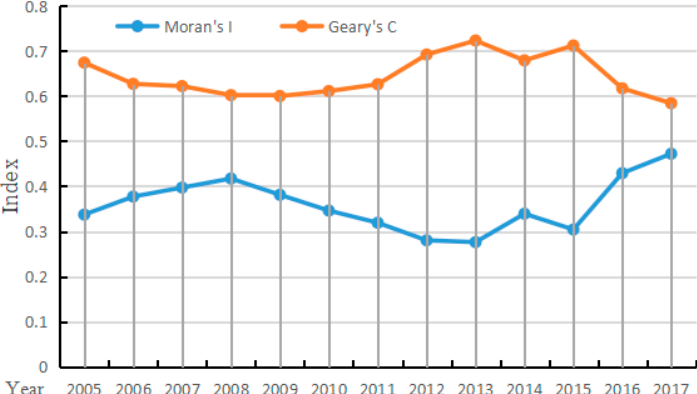
Figure 7. Moran’s I and Geary’s C, from 2005 to 2017.